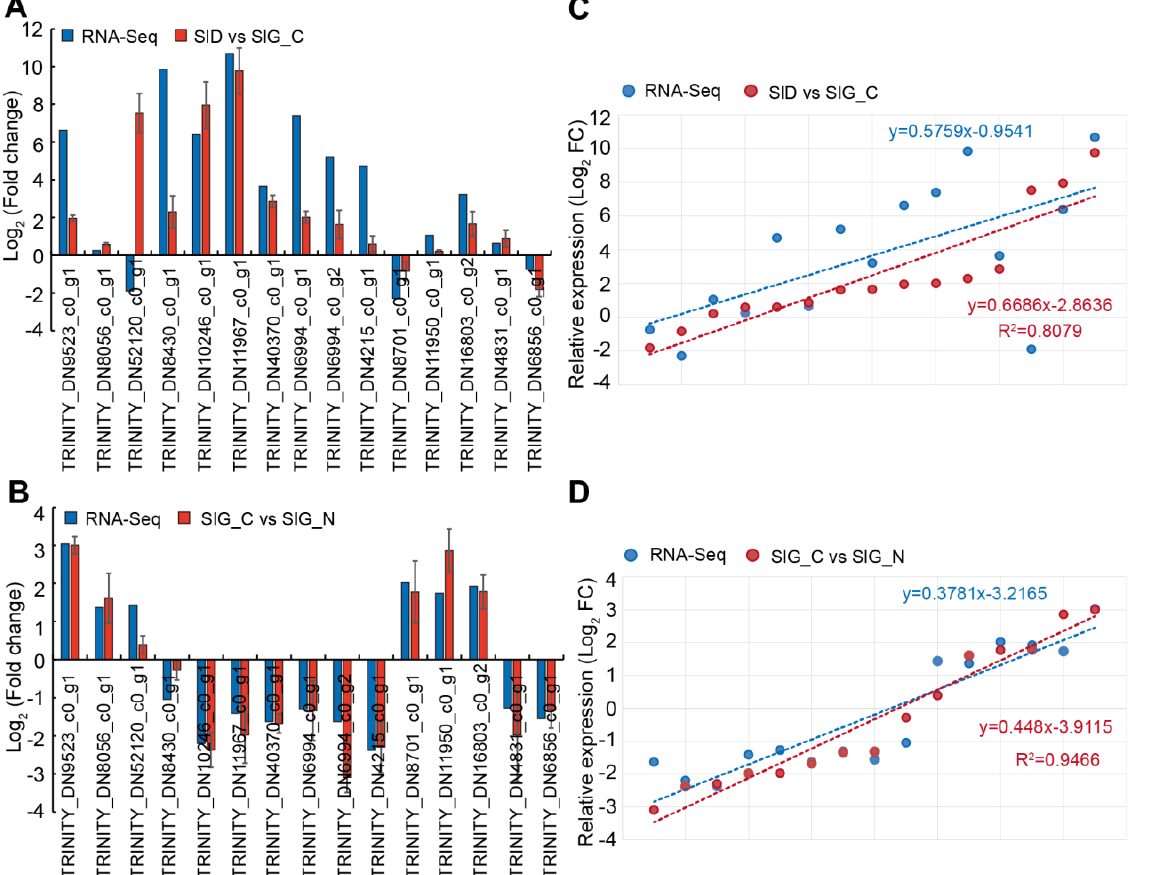
Figure 7. RT – qPCR validation of 15 candidate DEGs in the SlD vs. SlG_C ( A ) and SlG_C vs. SlG_N Figure 7. RT–qPCR validation of 15 candidate DEGs in the SlD vs. SlG_C ( A ) and ( B ) groups. Correlation between RNA – seq and RT – qPCR in the SlD vs. SlG_C ( C ) and SlG_C vs.